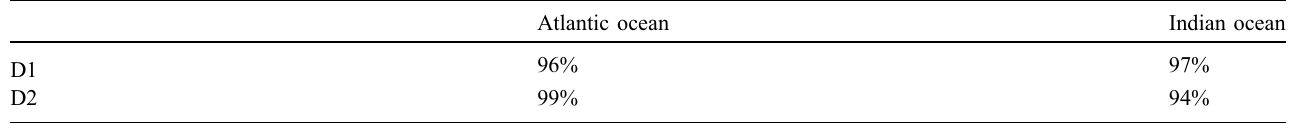
Table 4. Simple matching coef fi cients (percentage of agreement) between the random forest and the kinetic algorithm classi fi cations for the different datasets in the Atlantic and Indian Oceans.